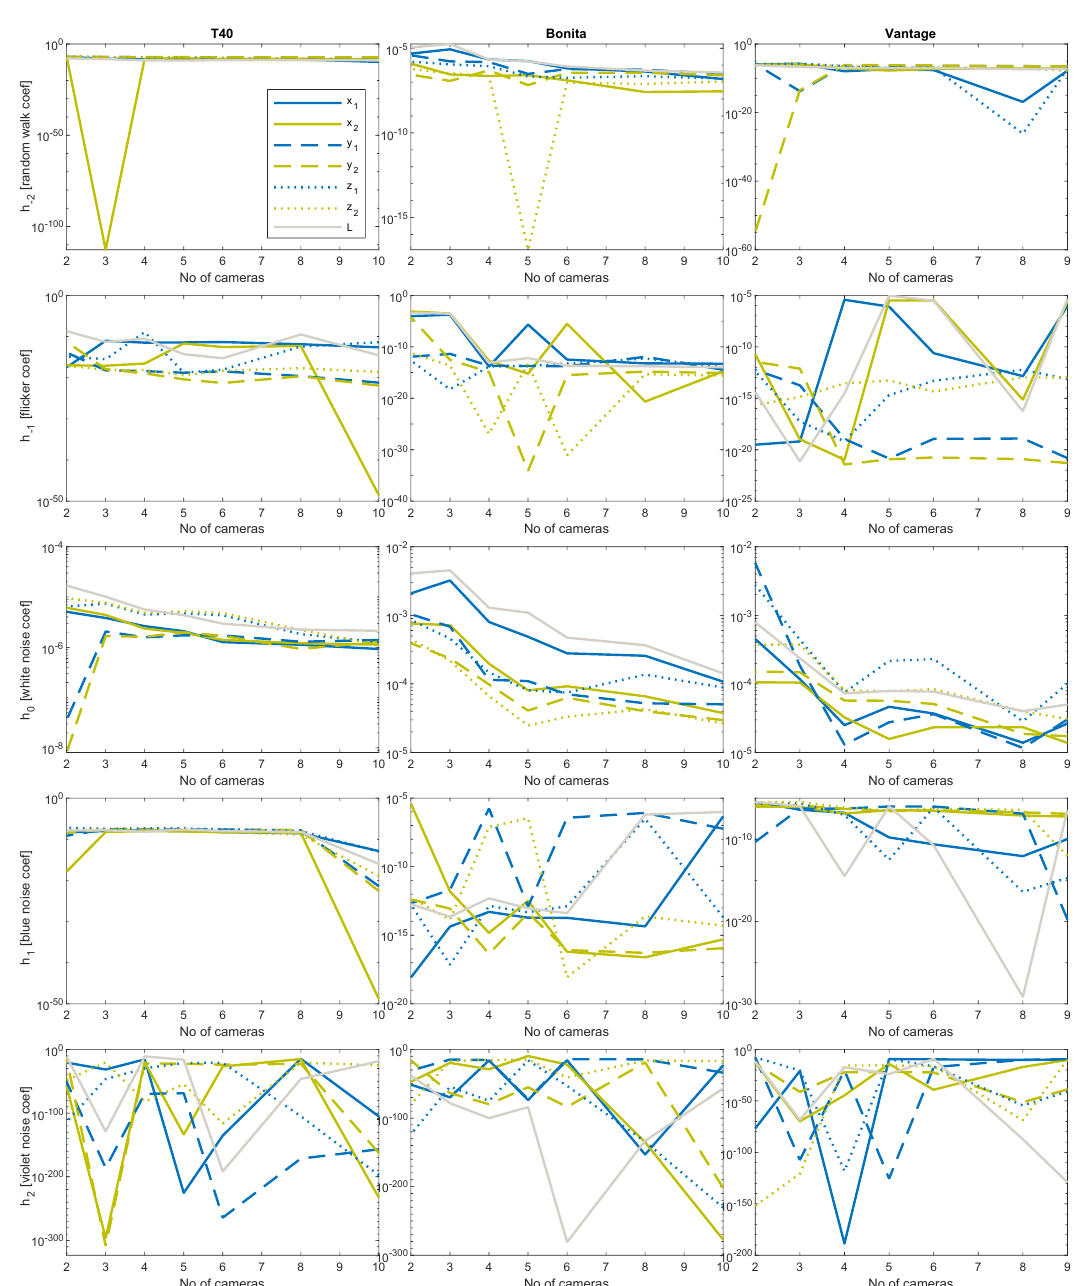
Figure 14. Color noises ( h − 2 ... h 2 ) coefficients in logarithmic scale; in columns left to right: T40, Bonita,